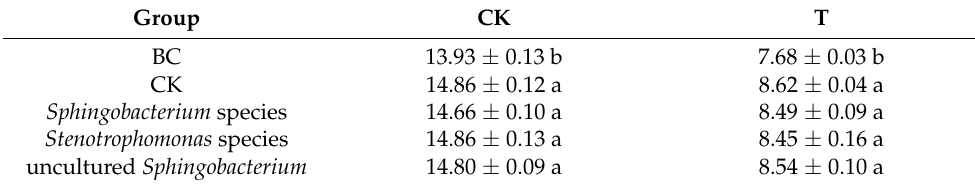
Table 8. Larval development duration after recolonization of cellulase-producing